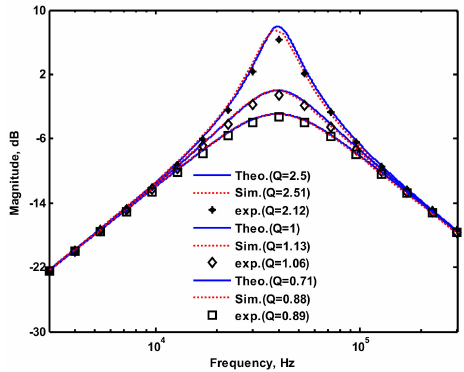
Figure 13. Simulation and experimental results of BP filtering responses at V o2 when V i1 = V in and V i2 = 0.